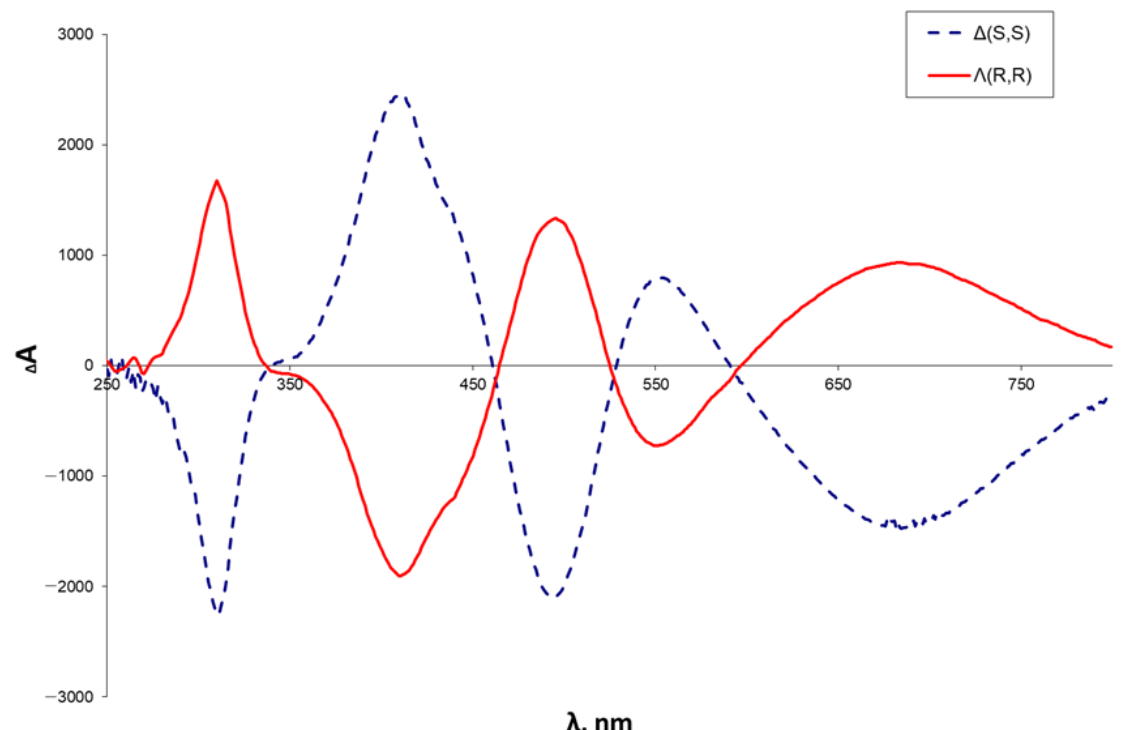
Figure 3. CD spectra of the complexes Λ ( R , R )- 2 ( red curve ) and ∆ ( S , S )- 2 ( blue dash curve ) recorded in CH 3 OH (c = 0.19 × 10 − 3 M) .